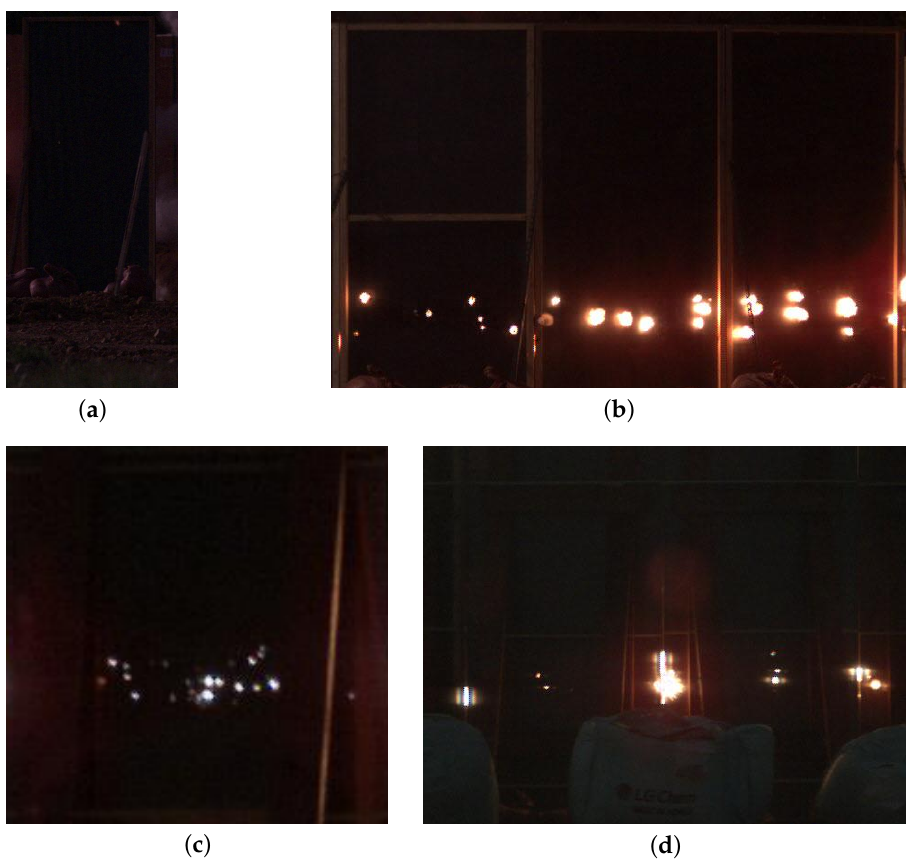
Figure 13. Sampled images collected from four different environments of AFT. ( a ) Case 1. ( b ) Case 2. ( c ) Case 3. ( d ) Case